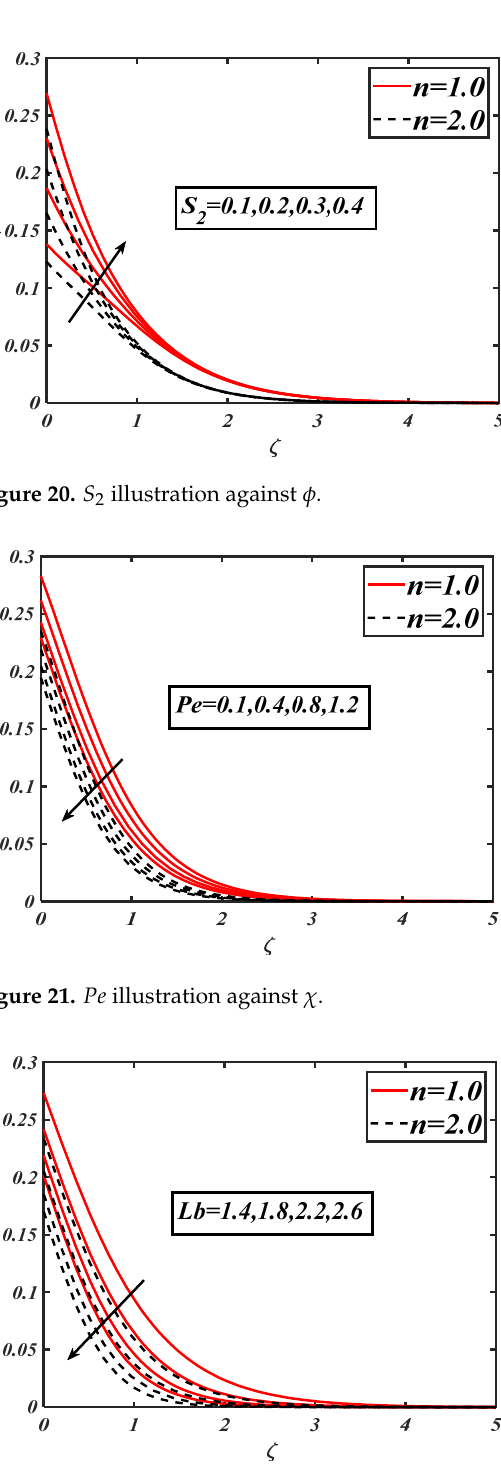
Figure 19. N illustration against